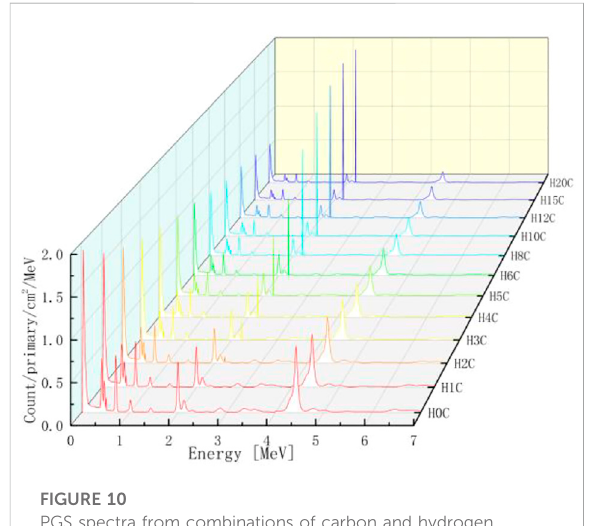
FIGURE 10 PGS spectra from combinations of carbon and hydrogen.